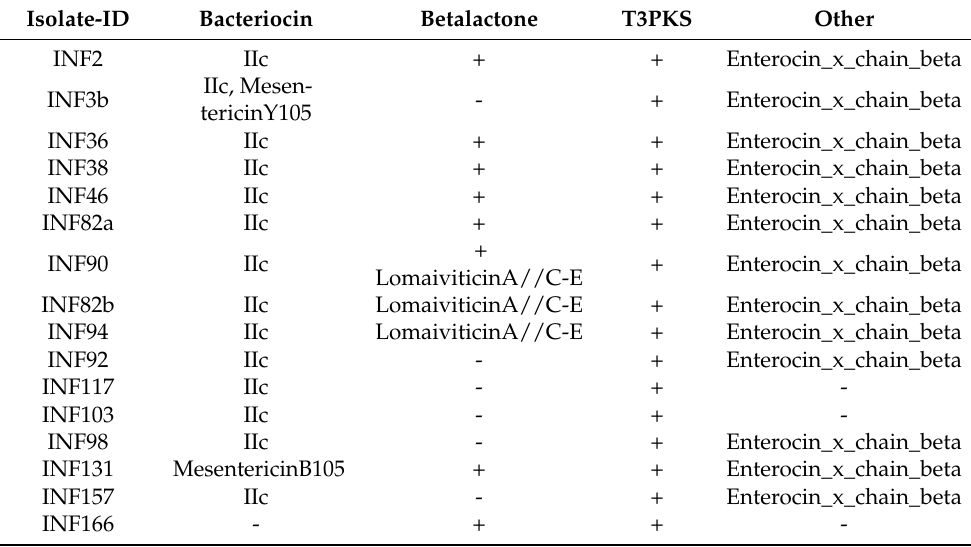
Table 2. Genes of the bacteriocin gene cluster and biosynthesis of secondary metabolites identified by BAGEL4 and